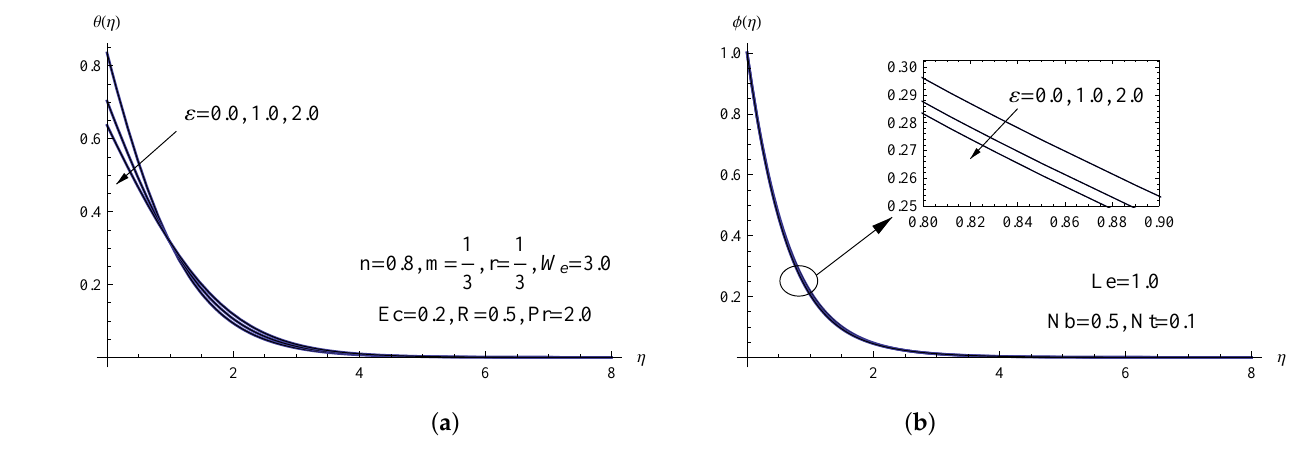
Figure 5. ( a ) θ ( η ) via ε ; ( b ) φ ( η ) via ε . Figure 6 displays a graph illustrating the relationship between temperature θ ( η ) and the concentration φ ( η ) of nanoparticles as the Eckert number Ec varies. The graph of nanoparticle concentration increases slightly with increasing Eckert number value, as does the temperature of the nanofluid but with a significantly variance behavior. If we look at Megahed’s earlier published work [27] on the Eckert number, the current results are also supported by it.